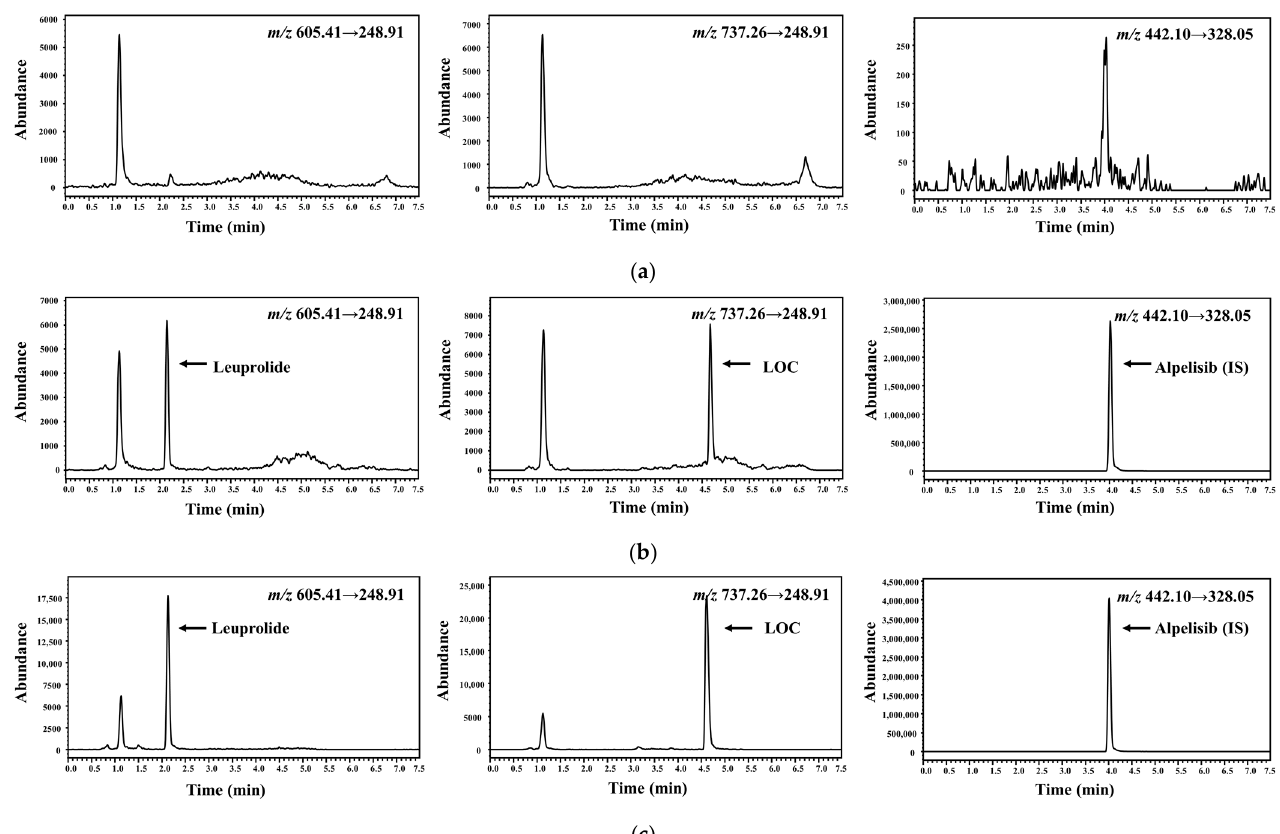
Figure 2. Representative chromatograms of leuprolide, LOC, and IS in rat plasma samples. ( a ) Blank rat plasma. ( b ) Blank rat plasma spiked with analytes [1 ng/mL, lower limit of quantification (LLOQ)]. ( c ) Plasma sample collected at 60 min after subcutaneous administration at a dose of 0.122 mg/kg of LOC (0.1 mg/kg in terms of leuprolide) in rats, wherein the calculated concentrations of leuprolide and LOC were 1.86 and 11.7 ng/mL, respectively.